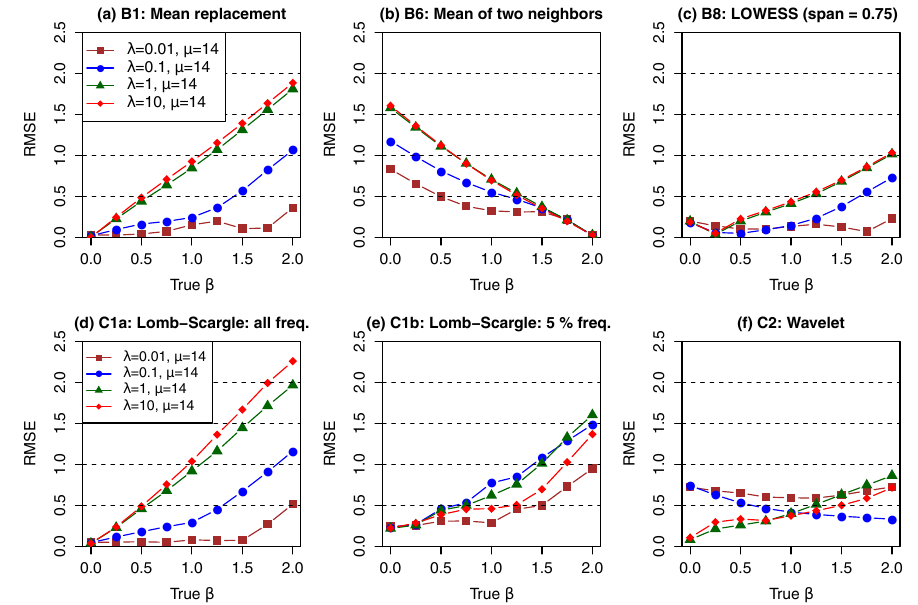
Figure 9. Comparison of root-mean-squared error (RMSE) in estimated spectral slope in irregular data that are simulated with varying prescribed β values (100 replicates), a series length of 9125, and a mean gap interval of 15 (i.e., µ = 14).